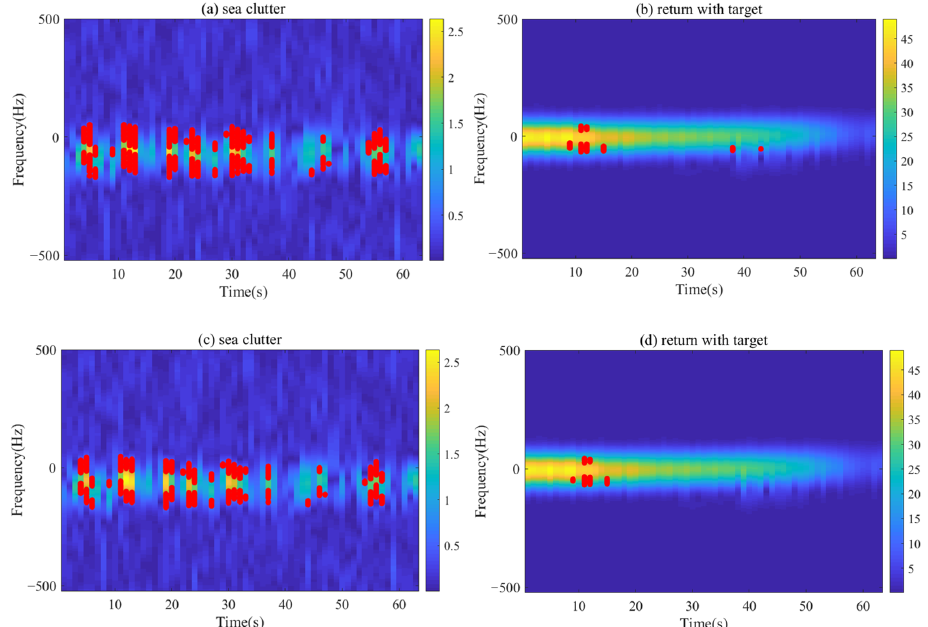
Figure 2. Distribution contrast of CFPs between sea clutter and target returns of #54 data at the HH polarization. ( a ) Spectrogram of sea clutter containing CFPs. ( b ) Spectrogram of target returns containing CFPs. ( c ) Spectrogram of sea clutter containing CFPs after optimization. ( d ) Spectrogram of target returns containing CFPs after optimization.